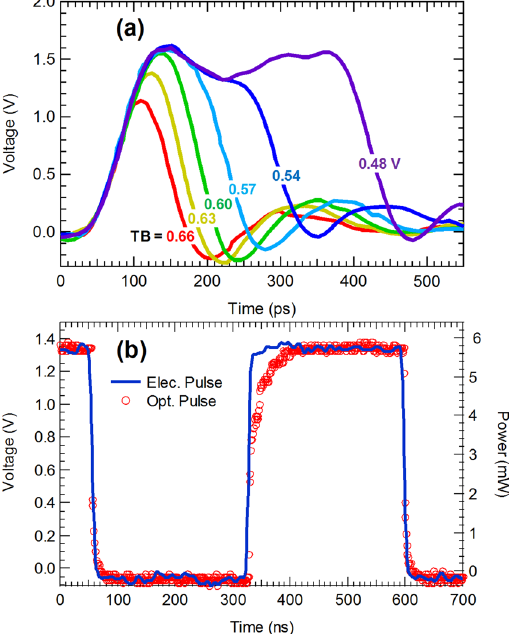
Figure 3. Results of the electrical measurements taken on the integrated CMOS pulser. ( a ) Waveforms of the output pulses with different pulse widths from the CMOS pulser with different voltage of TB from 0.66 to 0.48 V. Each waveform is marked with the corresponding voltage. ( b ) Waveform of the electrical pulse from the CMOS pulser with a duration of 270 ns and the corresponding optical pulse from the laser